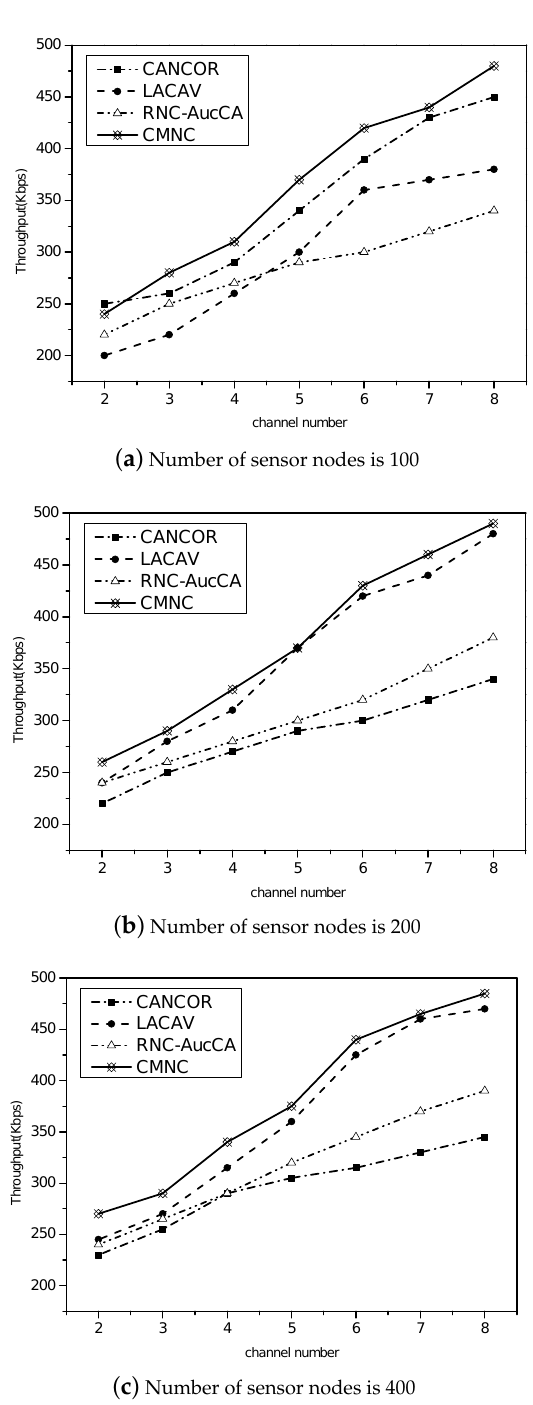
Figure 6. The relationship between the throughput and the number of sensor